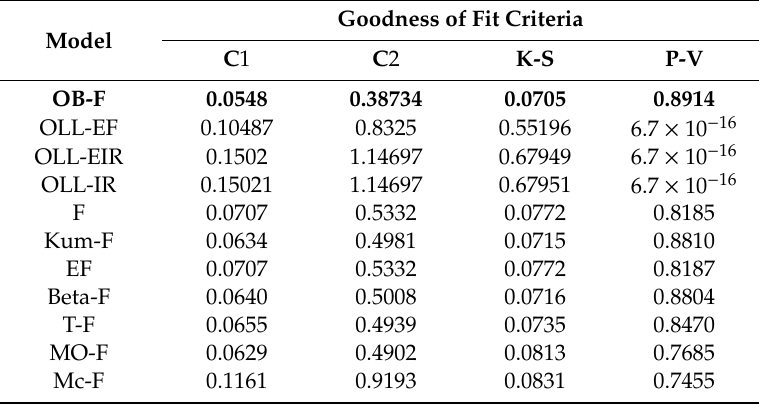
Table 9. C1, C2, K-S, and P-V for data set II.